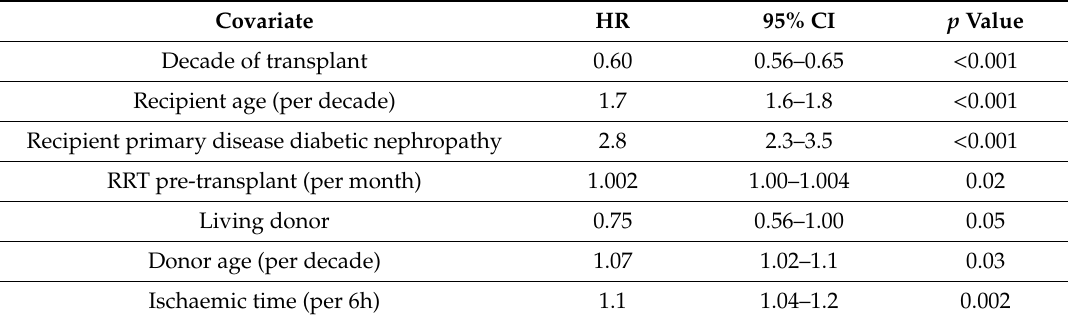
Table 4. Multivariate analysis for recipient survival in all